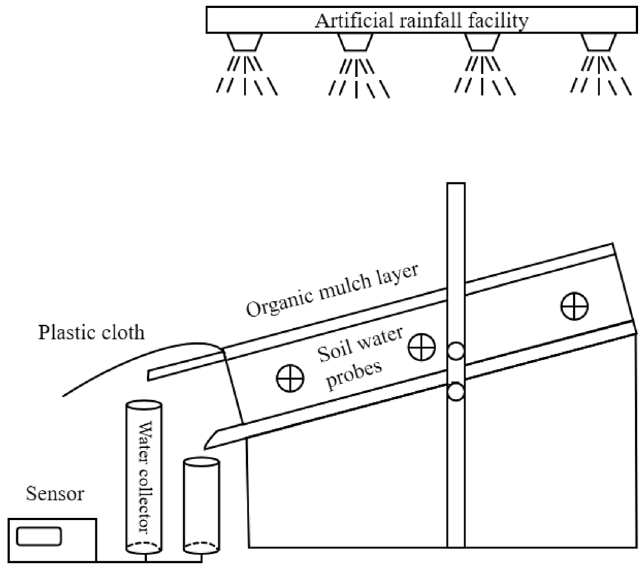
Figure 1. Experimental setup for rainfall and runoff effects of mulch cover.